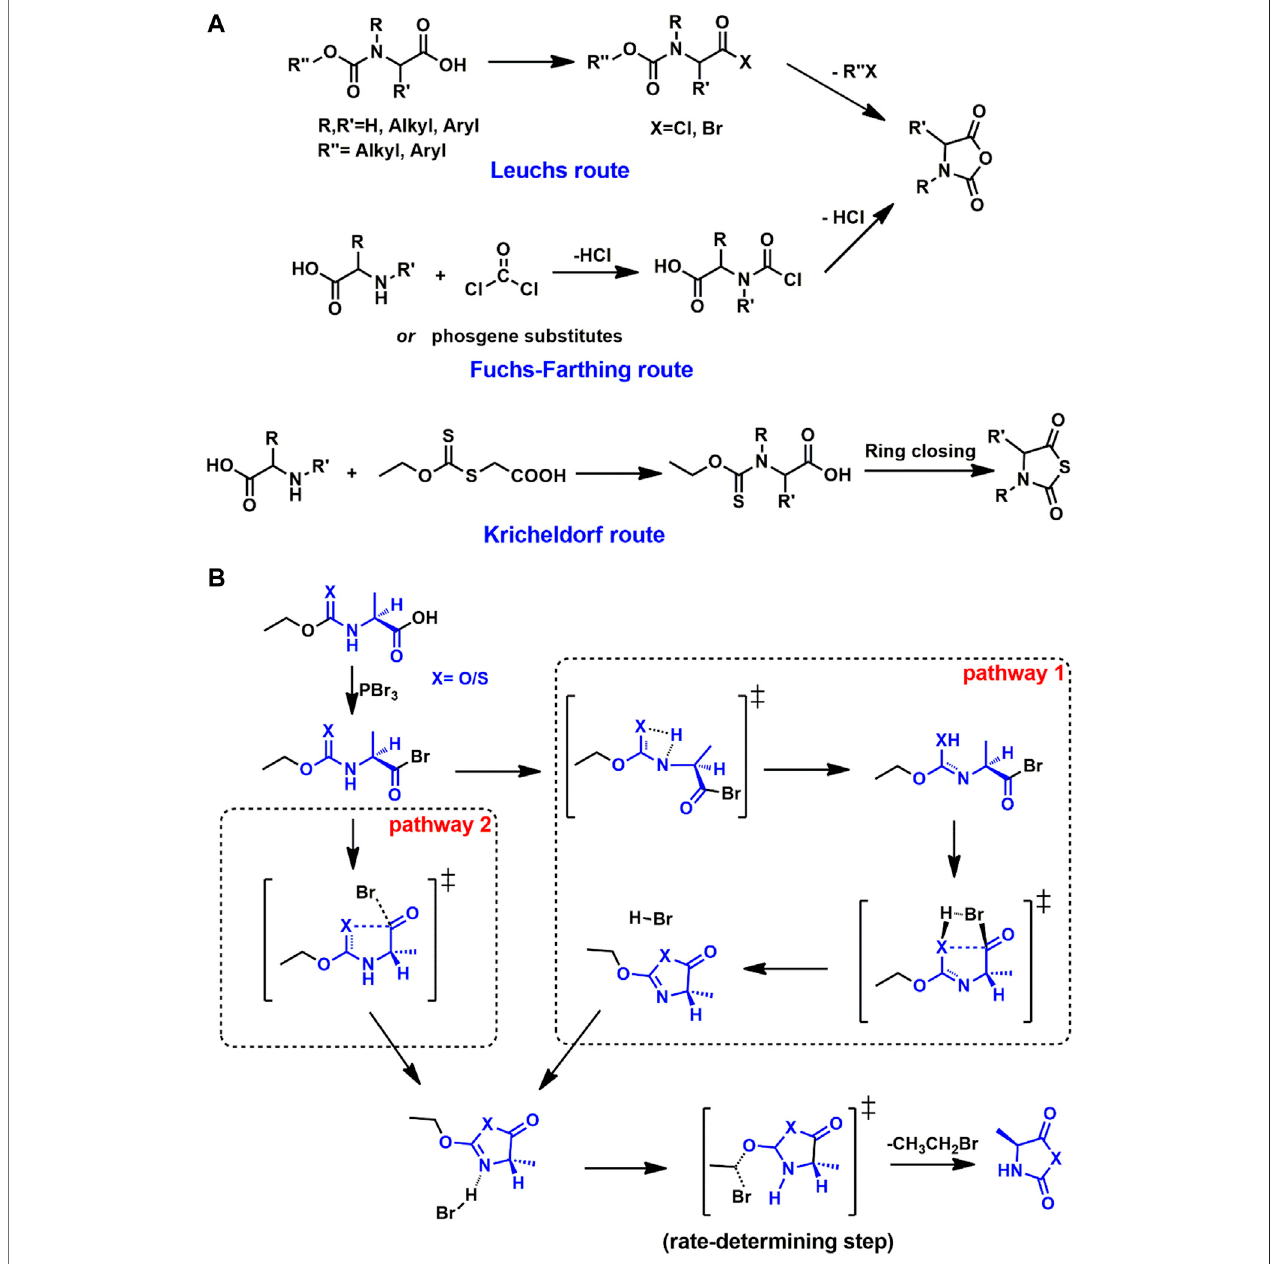
FIGURE 1 | (A) Syntheses of NCA monomers via Leuchs and Fuchs-Farthing routes and NTA monomers via Kricheldorf route. (B) Two possible ring-closing pathways toward Ala-NCA and Ala-NTA following Leuchs route or Kricheldorf.